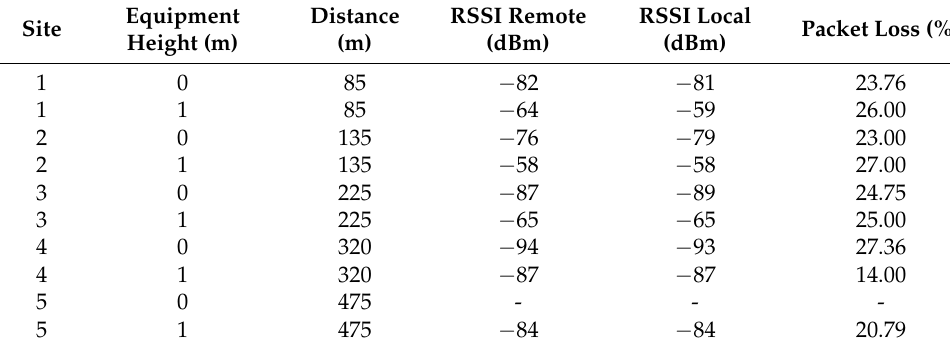
Table 2. Results obtained in the communications test of XBee modules.